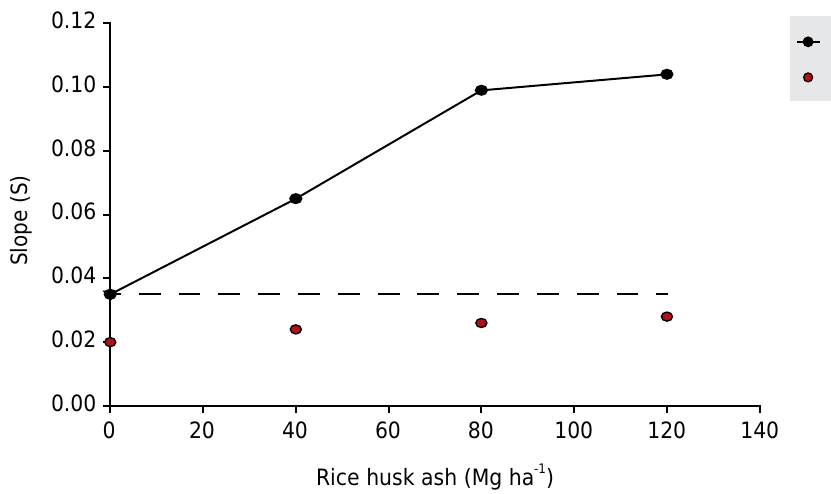
Figure 6. S parameter of a Typic Hapludult under different rates of rice husk ash in the 0.00-0.10 and 0.10-0.20 m layers. The dotted line indicates the critical value for crop.